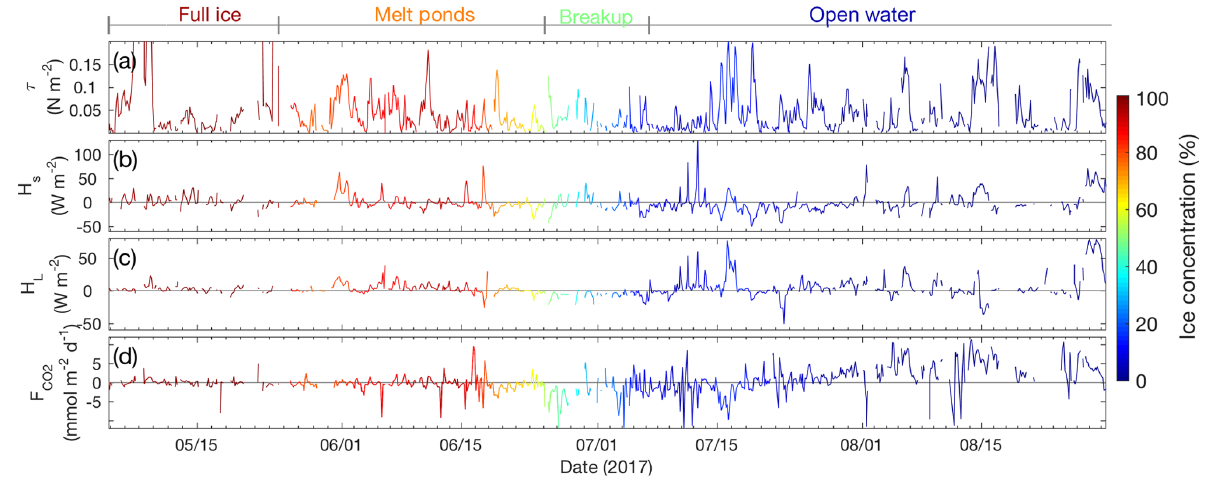
Figure 8. The 3h averages of measured fluxes, following the meteorological conventions (negative fluxes indicate transport towards the surface): (a) momentum flux (Nm − 2 ), (b) sensible heat flux (Wm − 2 ), (c) latent heat flux (Wm − 2 ), and (d) CO 2 flux (mmolm − 2 d − 1 ), measured by the closed-path IRGA. Ice concentration from the AMSR2 ice product is shown by color, with red representing full ice cover and blue representing open water. Demarcations (determined from satellite and in situ images) of ice regimes (full ice, melt ponds, breakup, and open water) are shown on top.